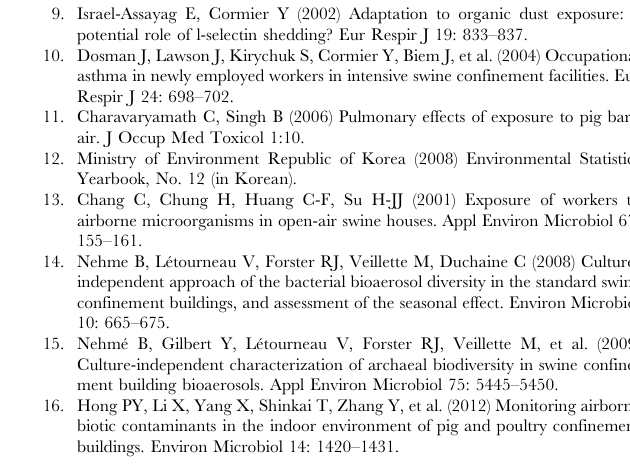
Figure S1 Indoor plan view of sampling points (circles) in swine confinement buildings. The microclimate variables were measured from 3 points (P1, P2 and P3) and aerosol samples were collected from the middle point (P2) in the aisle outside the pens. (TIF) Figure S2 Venn diagrams showing the overlap of OTUs (at 97% similarity) between winter and summer sea- sons. All samples in each season were pooled and then the percentage of shared and season-specific OTUs was calculated. (TIFF) Table S1 Q-PCR primers used to quantify the abun- dance of 16S rRNA genes and tetracycline resistance